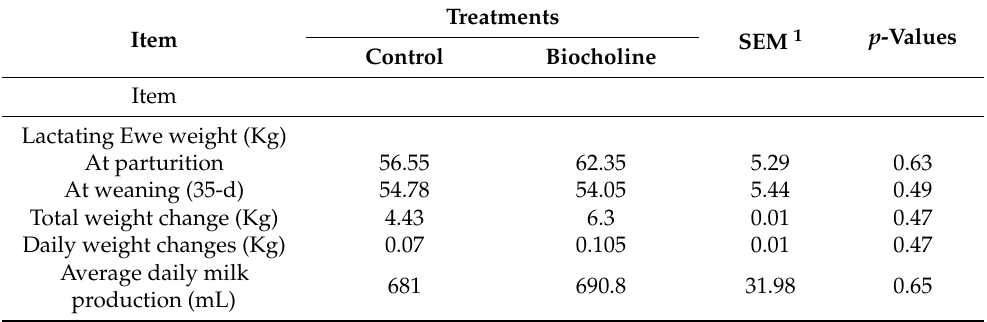
Table 1. Productive performance of Rambouillet ewes supplemented with an herbal mix as a source of choline during early gestation.